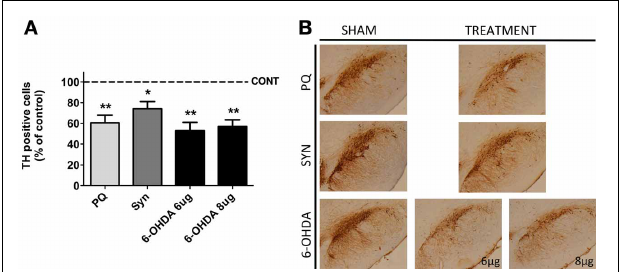
FIGURE 1 | Dopaminergic cell loss induced by PQ, α -syn overexpression and 6-OHDA. Eleven weeks after lesion, the animals were sacrificed and the substantia nigra region was processed for tyrosine hydroxylase (TH) immunohistochemistry (A) . Representative photomicrographs of midbrain sections immunostained for TH are presented in (B) . Data are expressed as the percentage of control animals and represent the mean ± s.e.m. of at least five animals per group. ∗ P < 0 . 05 and ∗∗ P < 0 . 01 compared to